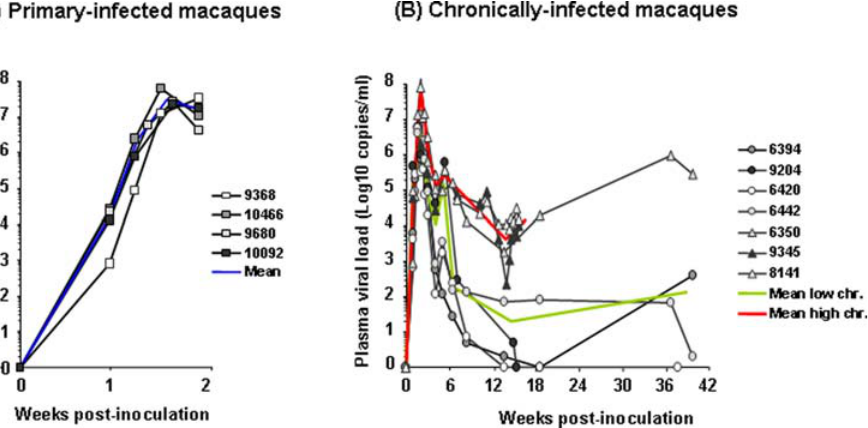
Figure 2. Blood PVLs from time of intravenous SIVmac251 inoculation to necropsy. (A) Four animals were sacrificed at 14 days p.i.; (B) Seven animals, sacrificed between 15 to 37 weeks p.i., were distinguished into one group of 3 ‘‘high chronic animals’’ (triangles) and one group of 4 ‘‘low chronics’’ (circles), based on PVL at necropsy. Mean viral loads are represented by a blue line for the primary-infected, a red line for the chronically-infected animals with high PVL and a green line for the chronically infected animals with low PVL.